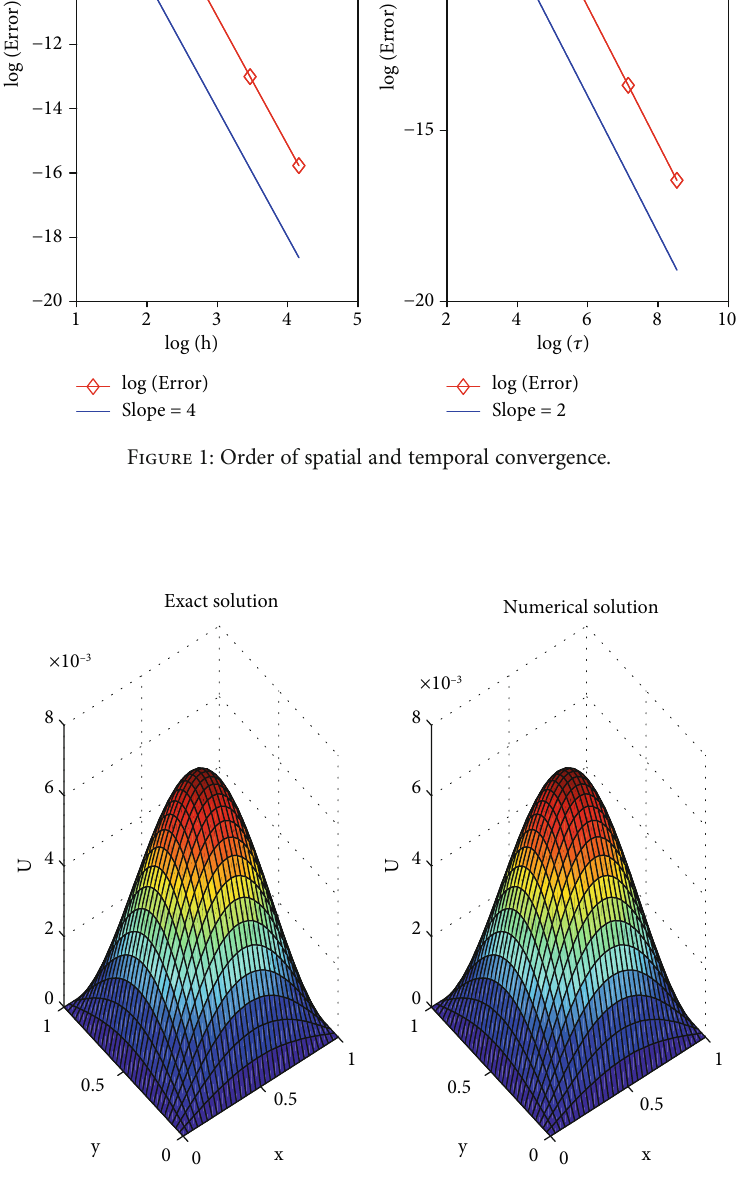
Figure 2: The exact solution and the numerical at fi xed D = 1 , ε 2 = 0 : 1 , T = 1 , h = 1/32 and τ = 1/1280